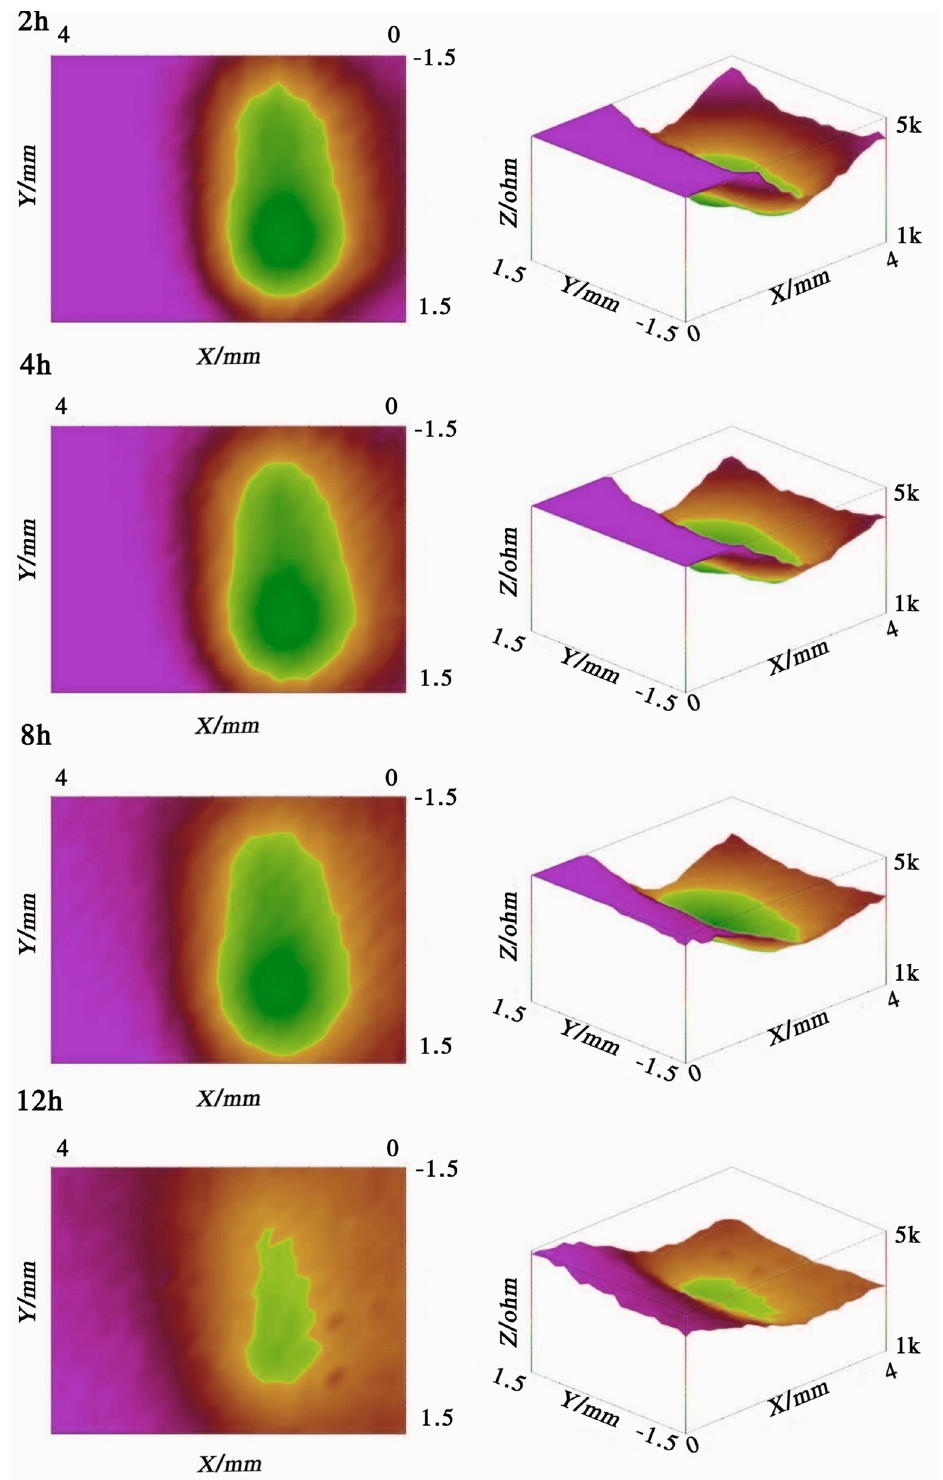
Figure 18. Local electrochemical impedance maps (LEIM) obtained for the 21PIP sample. Frequency: 10 Hz. Immersion time: 2, 4, 8 and 12 h. Electrolyte: 0.001 M NaCl aqueous solution.